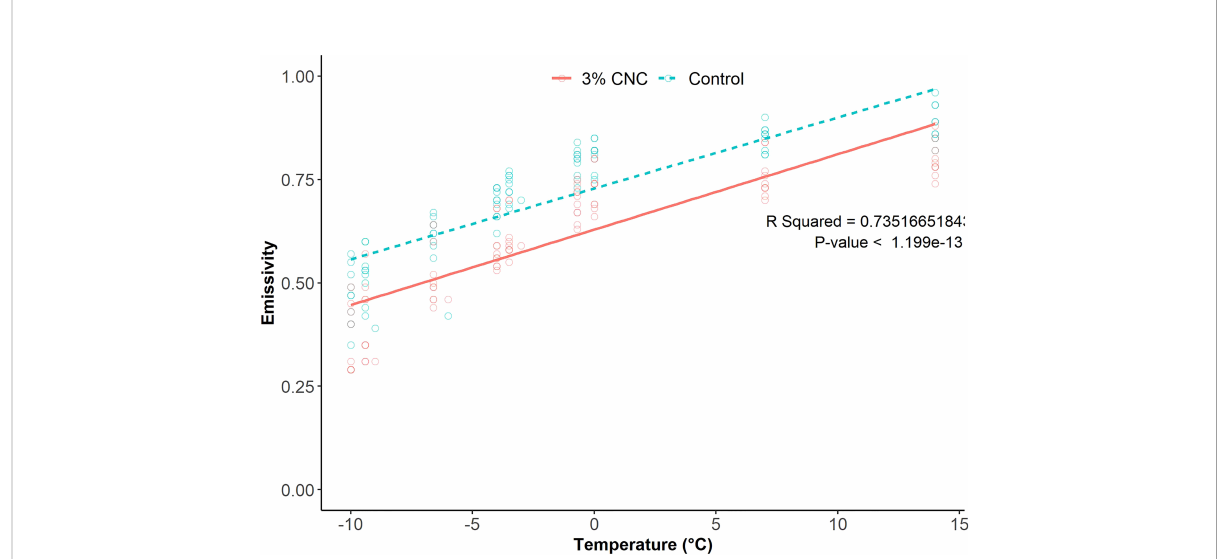
FIGURE 5 Plot and linear regression analysis of model-generated emissivity value from thermal images collected from cooling cherry fruit spurs ( n =